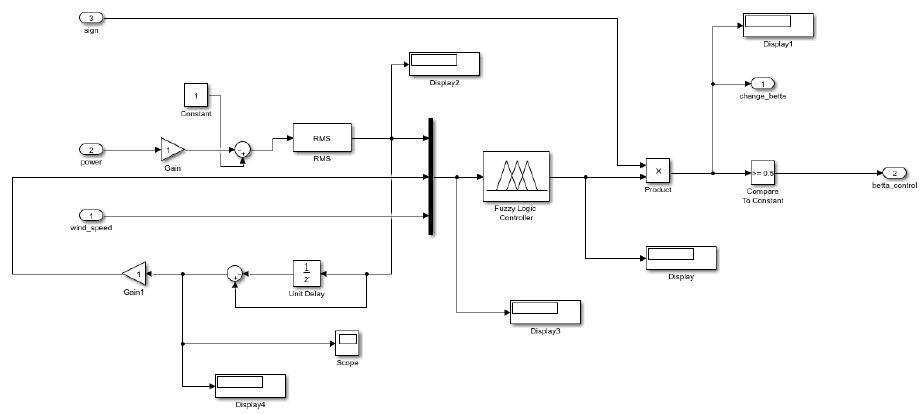
Figure 7. Pitch angle change block in MATLAB.